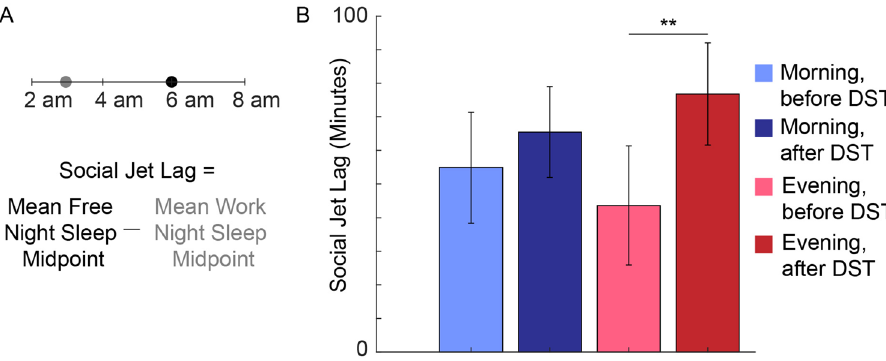
Figure 3. Social jet lag is significantly higher in the evening population after DST. ( A ) Schematic of the social jet lag calculation. For each individual with at least one work night sleep event and one free night sleep event, we calculate the mean sleep midpoint for the workweek and the mean sleep midpoint for the free nights. Then, social jet lag is defined as the difference between the mean free night sleep midpoint and the mean work night sleep midpoint. ( B ) For the morning population, social jet lag is consistent across the week before DST (n = 133 subjects) and the week after DST (n = 141 subjects). For the evening population, social jet lag significantly decreased (T-statistic = − 2.83, P = 0.0051) the week after DST (n = 134 subjects) compared with the week before DST (n = 118